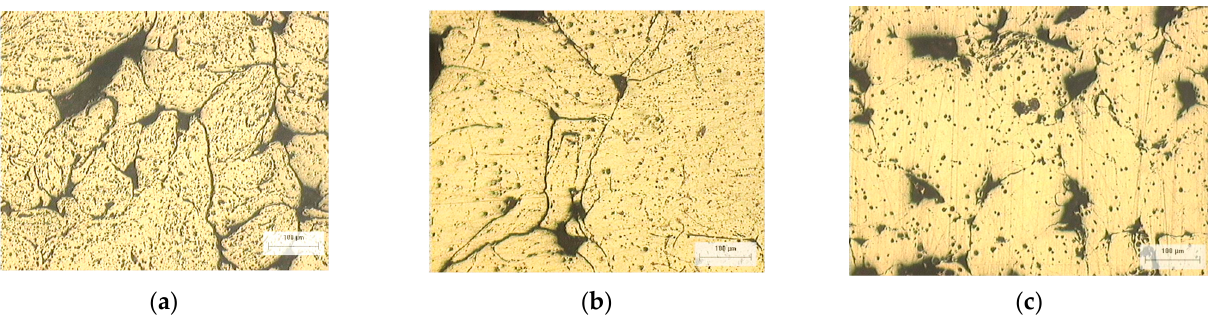
Figure 4. ( a ) Metallographic microstructure of the Alps. ( b ) Metallographic microstructure of the 75/0s composite. ( c ) Metallographic microstructure of the 300/0s composite.